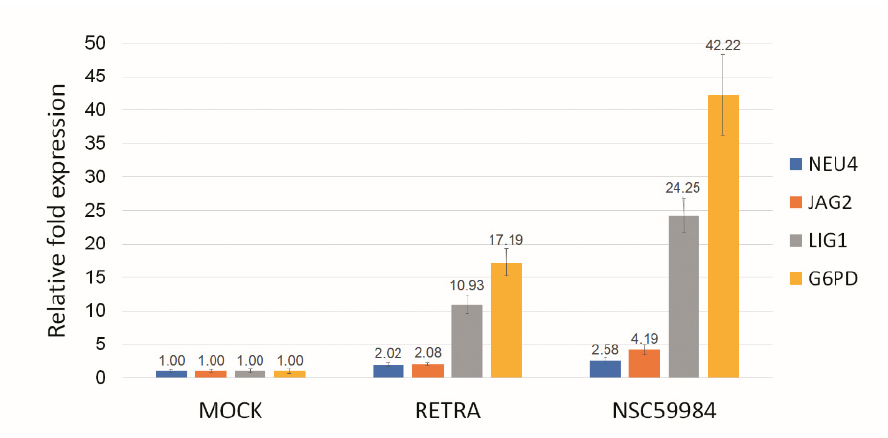
Figure 2. p73 activator(s) activate p73 downstream genes in OCEM-1 cells. RETRA (40 μ M) or NSC59984 (100 μ M) could upregulate p73 downstream genes NEU4, JAG2, LIG1 and G6PD in OECM-1 cells. Mock (DMSO only) was calculated as 1 to normalize for other conditions.